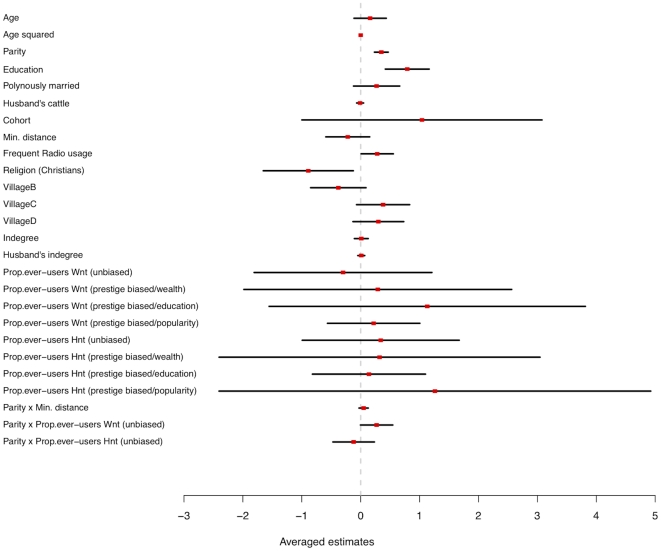
Averaged estimates (red squares) and 95% confidence intervals (black lines) for the effects of individual factors, social environment, and social interactions on the risk of first contraceptive use.Data cover a period of 14 years and involve >900 women (see Methods). Wnt: women's network; Hnt: husband's network; formal education is compared to the level “no education”; villages are compared to the first level “Village A”; Being polygynously married is compared to being “monogamously married”. “x” indicates an interaction.